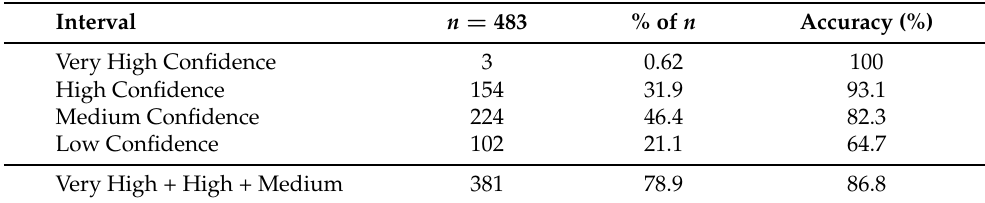
Table 5. Confidence Interval Distribution and Accuracy—WoC-Bots for Breast Cancer Metastasis Status.